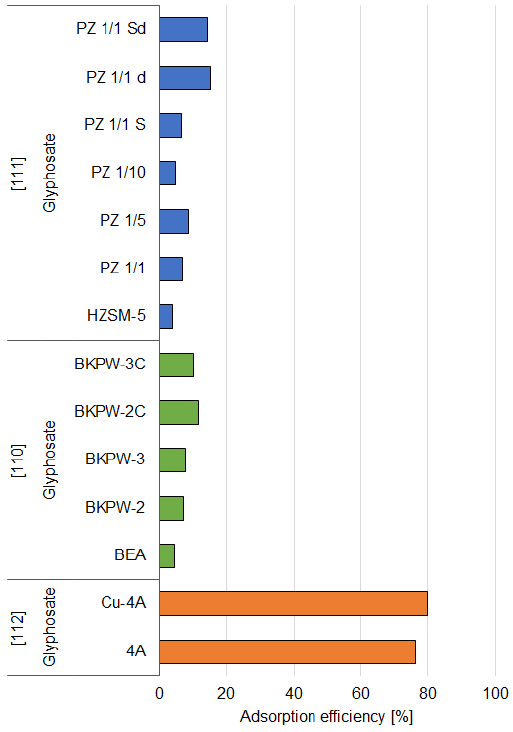
Figure 8. Effectiveness of removal of glyphosate-based pesticides by synthetic zeolites.